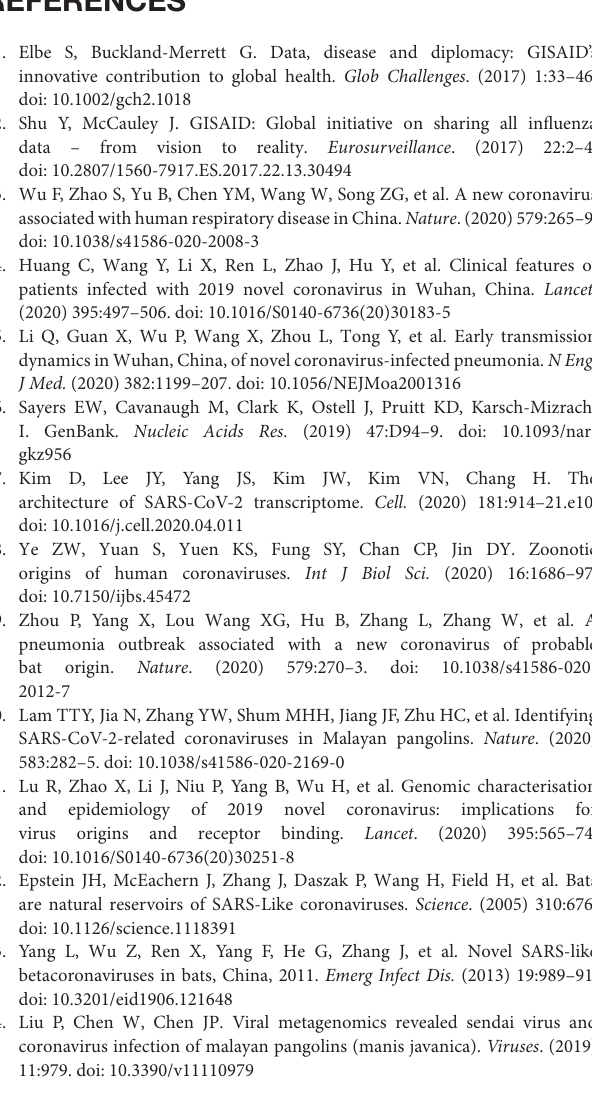
Supplementary Figure 4 | Results of a phylogenetic signal inference in our dataset by likelihood mapping analysis as implemented in IQTREE v2.0.6. Overall quartet resolution (out of 134,000 quartets) was as follows: number of fully resolved quartets (regions 1 + 2 + 3): 86,669 ( = 64.68%); number of partly resolved quartets (regions 4 + 5 + 6): 3,454 ( = 2.58%); number of unresolved quartets (region 7): 43,877 ( = 32.74%). Supplementary Table 1 | Annotation and occurrence of 247 variants identifiable among 133 Latvian SARS-CoV-2 isolates sequenced (sorted by occurrence). Supplementary Table 2 | Latvian SARS-CoV-2 isolate sequencing approaches. Supplementary Table 3 | 2019-nCoV RUO Kit (IDT) primers and probes for SARS-CoV-2